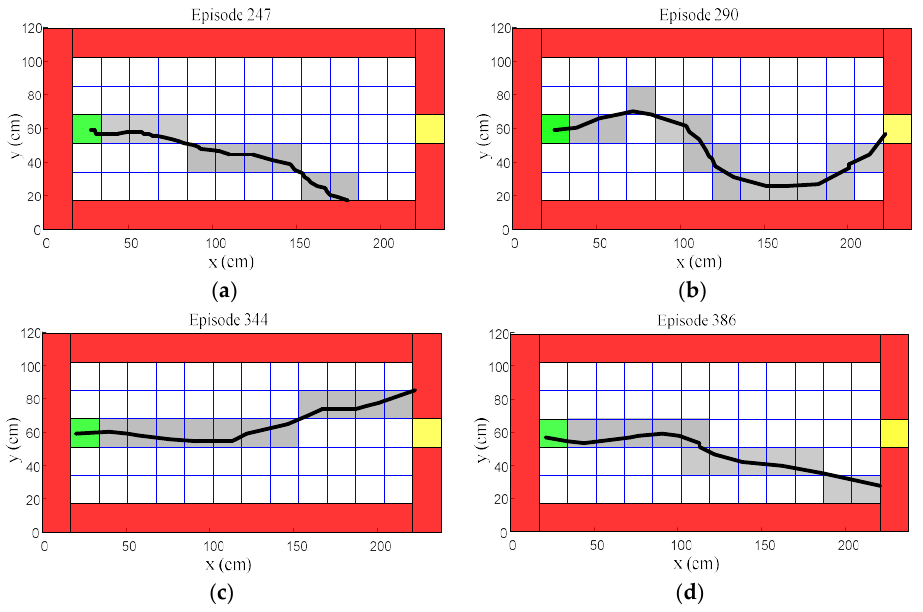
Figure 22. Results in the middle stage of the learning process: ( a ) episode 247; ( b ) episode 290; ( c ) episode 344; ( d ) episode 386.